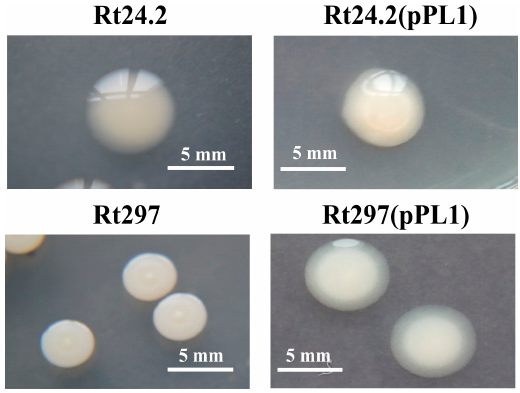
Figure 1. Morphology of colonies formed by the wild-type strain R. leguminosarum Rt24.2 and several derivatives: the mutant strain Rt297 ( pssZ ), complemented strain Rt297 (pPL1), and Rt24.2 (pPL1) harboring additional pssZ copies.